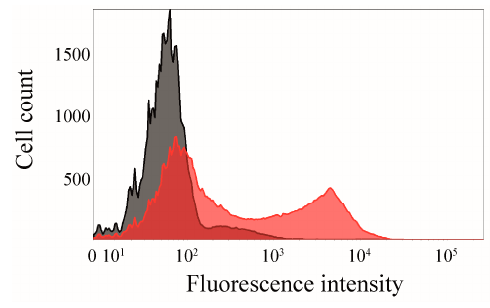
Figure 9. SPAAC reaction of CK2 β -AT-pAzF and DBCO545 on the surface of E. coli . Cells (OD 578 = 1) displaying CK2 β -AT-pAzF were incubated with the fluorophore DBCO545 (50 µM) for 1h at RT. After three washing steps, E. coli displaying CK2 β -AT-DBCO545 (red, mF = 1495) were analyzed by flow cytometry. As a control, surface translocated CK2 β -AT without incorporated unnatural amino acid pAzF was applied and treated identically (grey, mF = 120).